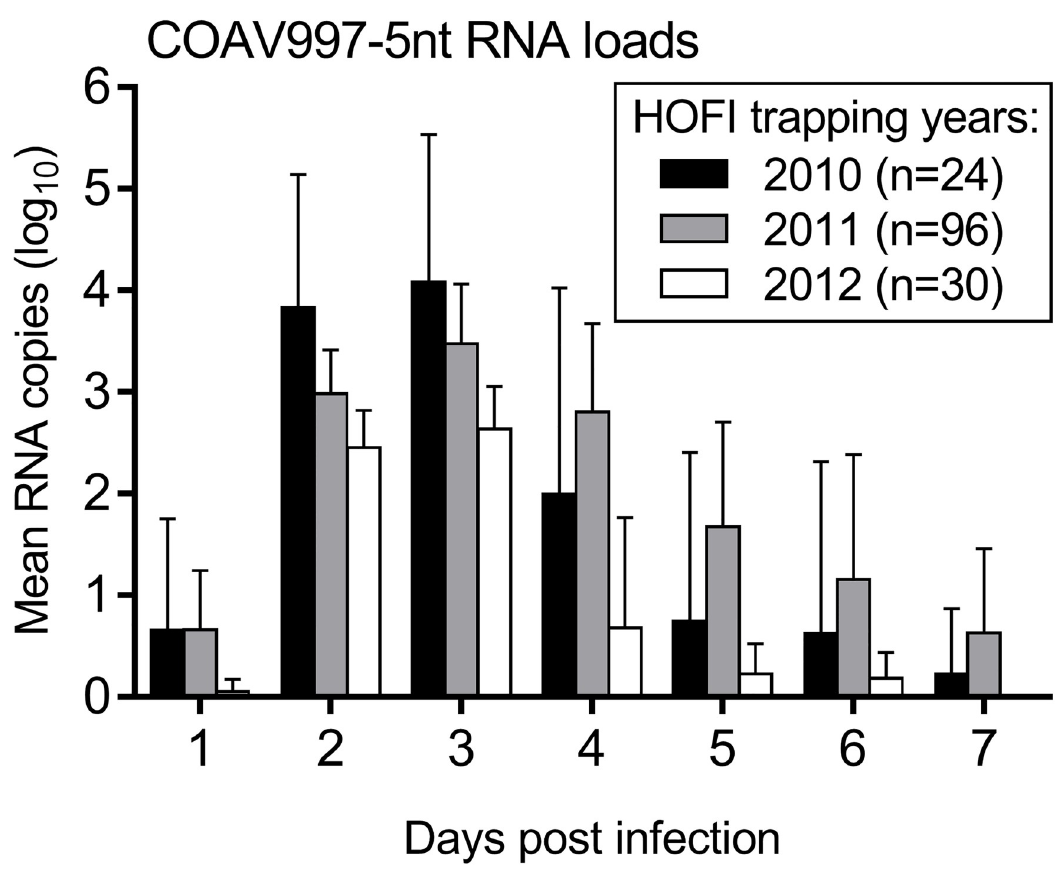
Fig 4. Varying competence of HOFIs to COAV997-5nt challenge. Bars show the mean daily COAV997-5nt RNA copies from hatch-year HOFIs trapped during 2010 (black color), 2011 (grey color) and 2012 (white color). The mean log 10 RNA copies of COAV997-5nt including standard deviation (error bars) detected in HOFI sera are plotted for days 1 through 7 following competitive challenge.